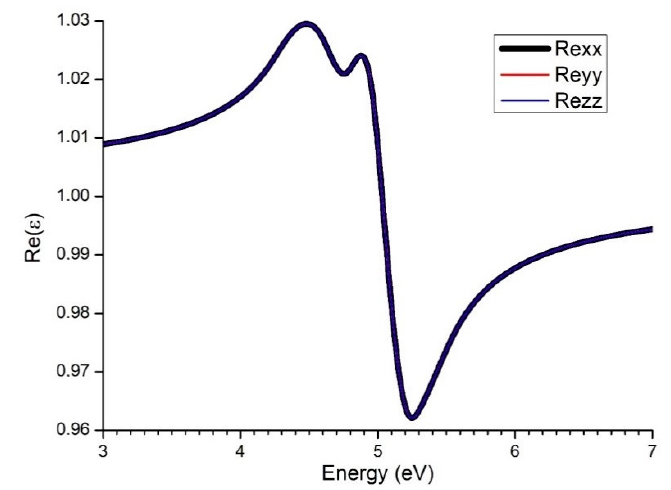
Figure 5. Real part of dielectric function.